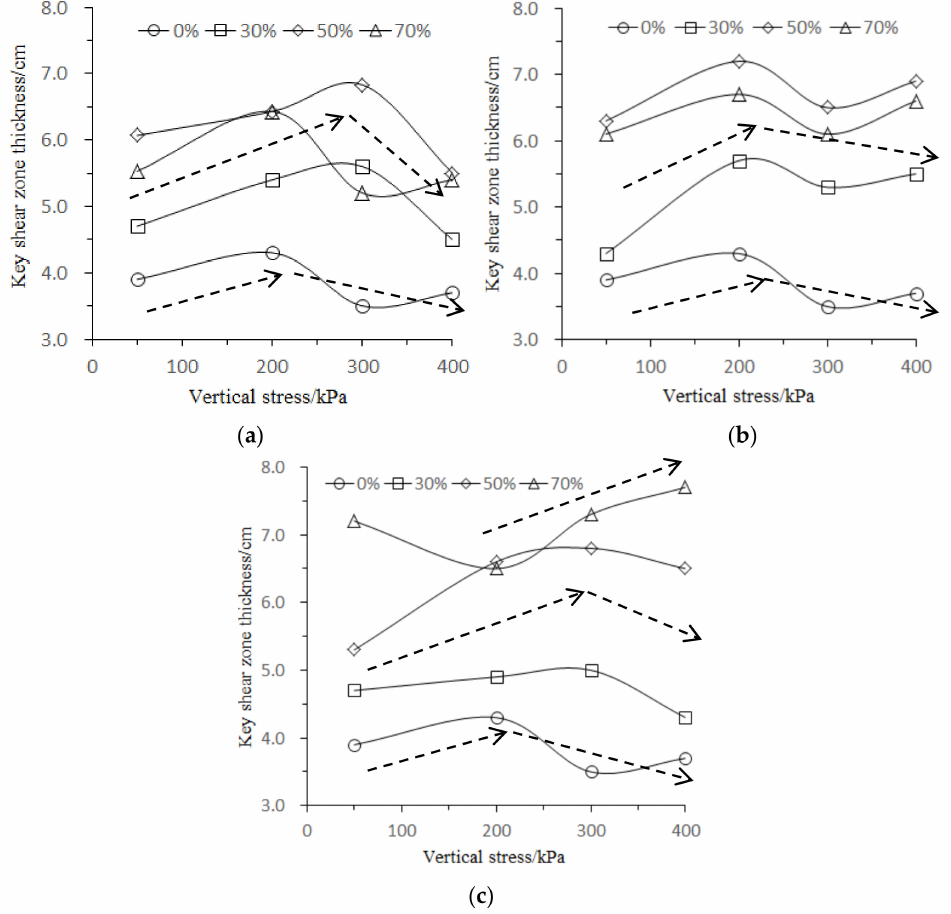
Figure 20. Variation in the key shear zone thickness with increasing vertical pressure for di ff erent stone sizes. ( a ) Stone size L 1; ( b ) stone size L 2; ( c ) stone size L